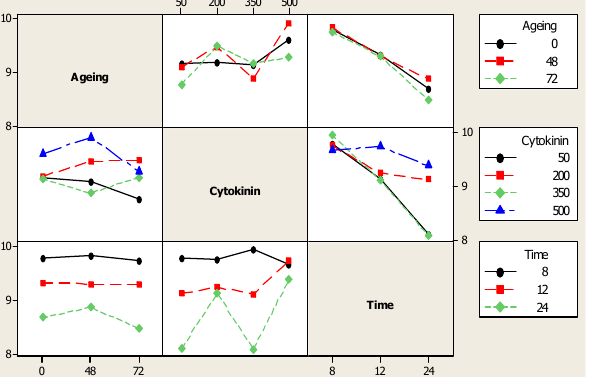
Fig. 5. Interaction plot of stem length under hormone seed priming and ageing treatments